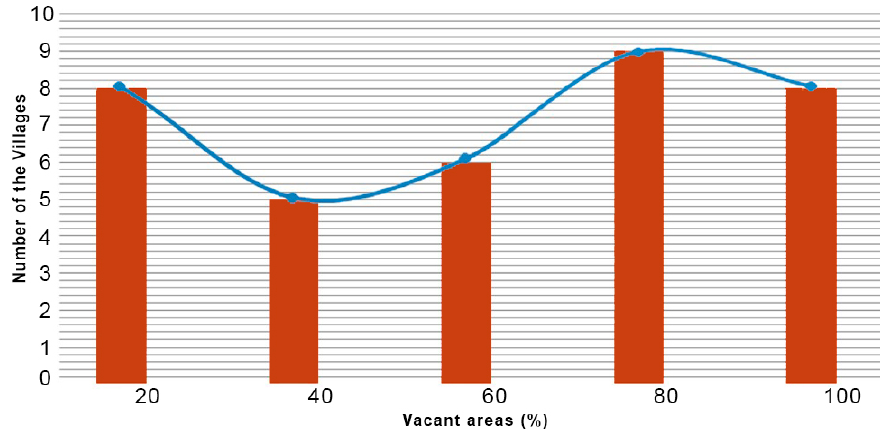
Figure 9. The histogram for the “Vacant area” index.